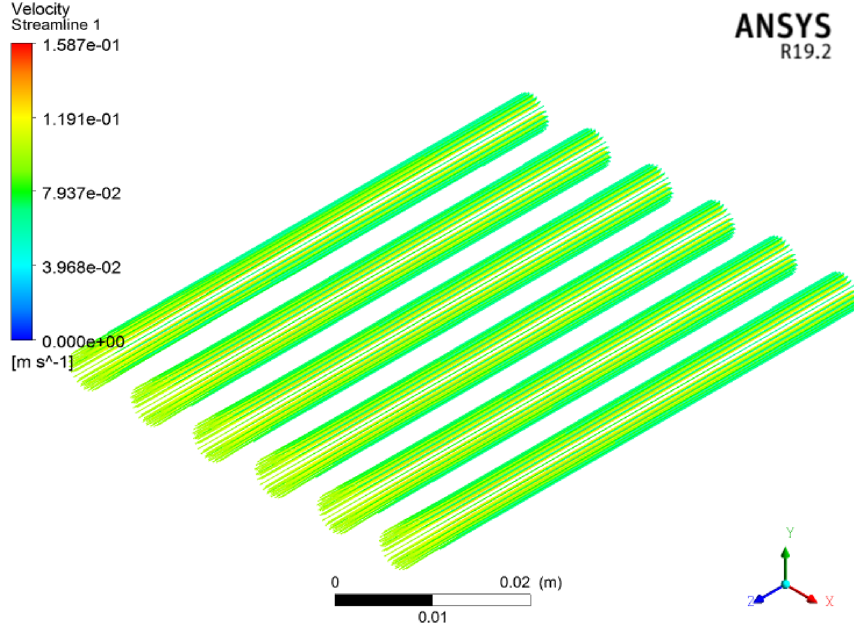
Figure 6. Velocity in micro channel heat